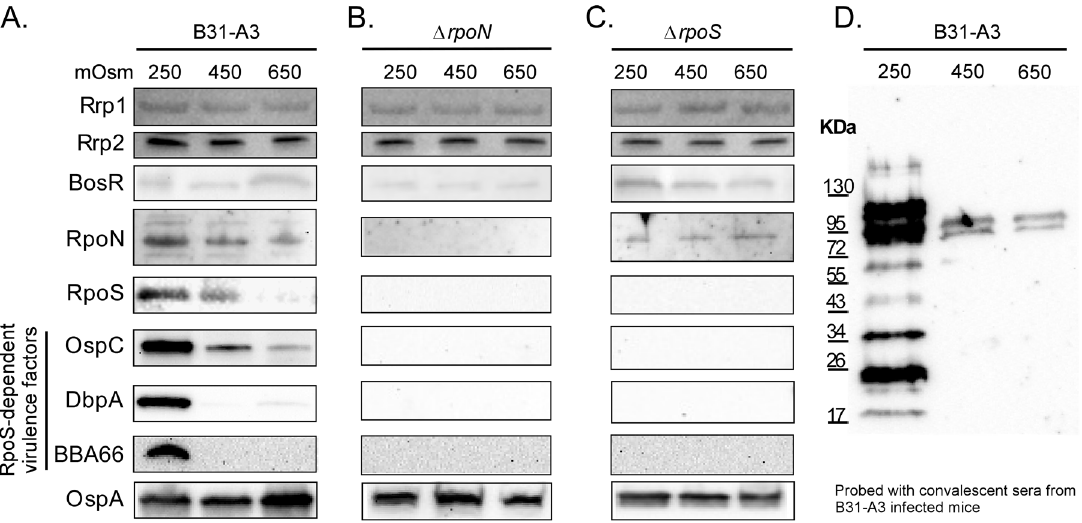
Fig 3. The effects of osmolarity on specific proteins regulated by the RpoN-RpoS regulatory cascade. B . burgdorferi strains B31-A3, B31-A3 Δ rpoN and B31-A3 Δ rpoS were grown in 250, 450 and 650 mOsm BSK-II to mid-log phase and cell lysates (40 μ g of protein/lane) were analyzed by immunoblotting. (A) B31-A3 lysates (40 μ g of protein/lane) were probed with OspA, OspC, DbpA, BBA66, RpoN, RpoS, BosR, Rrp1 and Rrp2 antigen-specific antisera. (B) B31-A3 Δ rpoN , and (C) B31-A3 Δ rpoS cell lysates probed with the same antigen-specific antisera. (D) B31-A3 (40 μ g protein/lane) cell lysates probed with serum from mice infected by B . burgdorferi via tick